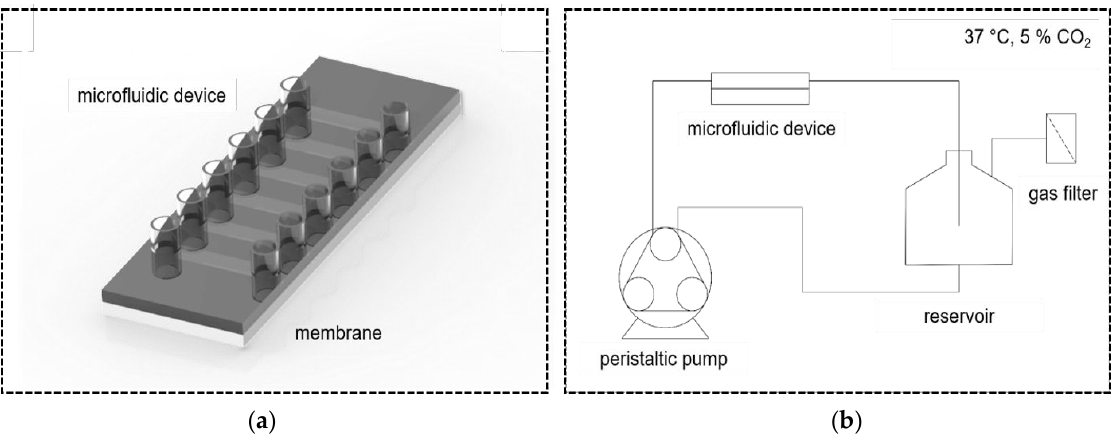
Figure 2. Dynamic culture of endothelial cells in microfluidic slides with ( a ): Microfluidic device with membrane mounted to the bottom side and six working channels; and ( b ): Bioreactor system with peristaltic pump and medium reservoir placed in a controlled atmosphere (37 °C, 5% CO 2 ). For endothelialization of the coated membranes, non-sprayed and sprayed (with a concentration of 2 × 10 6 cells/mL) HUVECs were suspended in EGM2 with 1% ABM